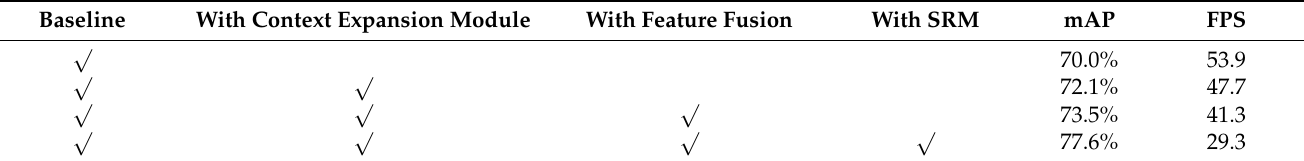
Table 2. Effectiveness of each design on VEDAI dataset.